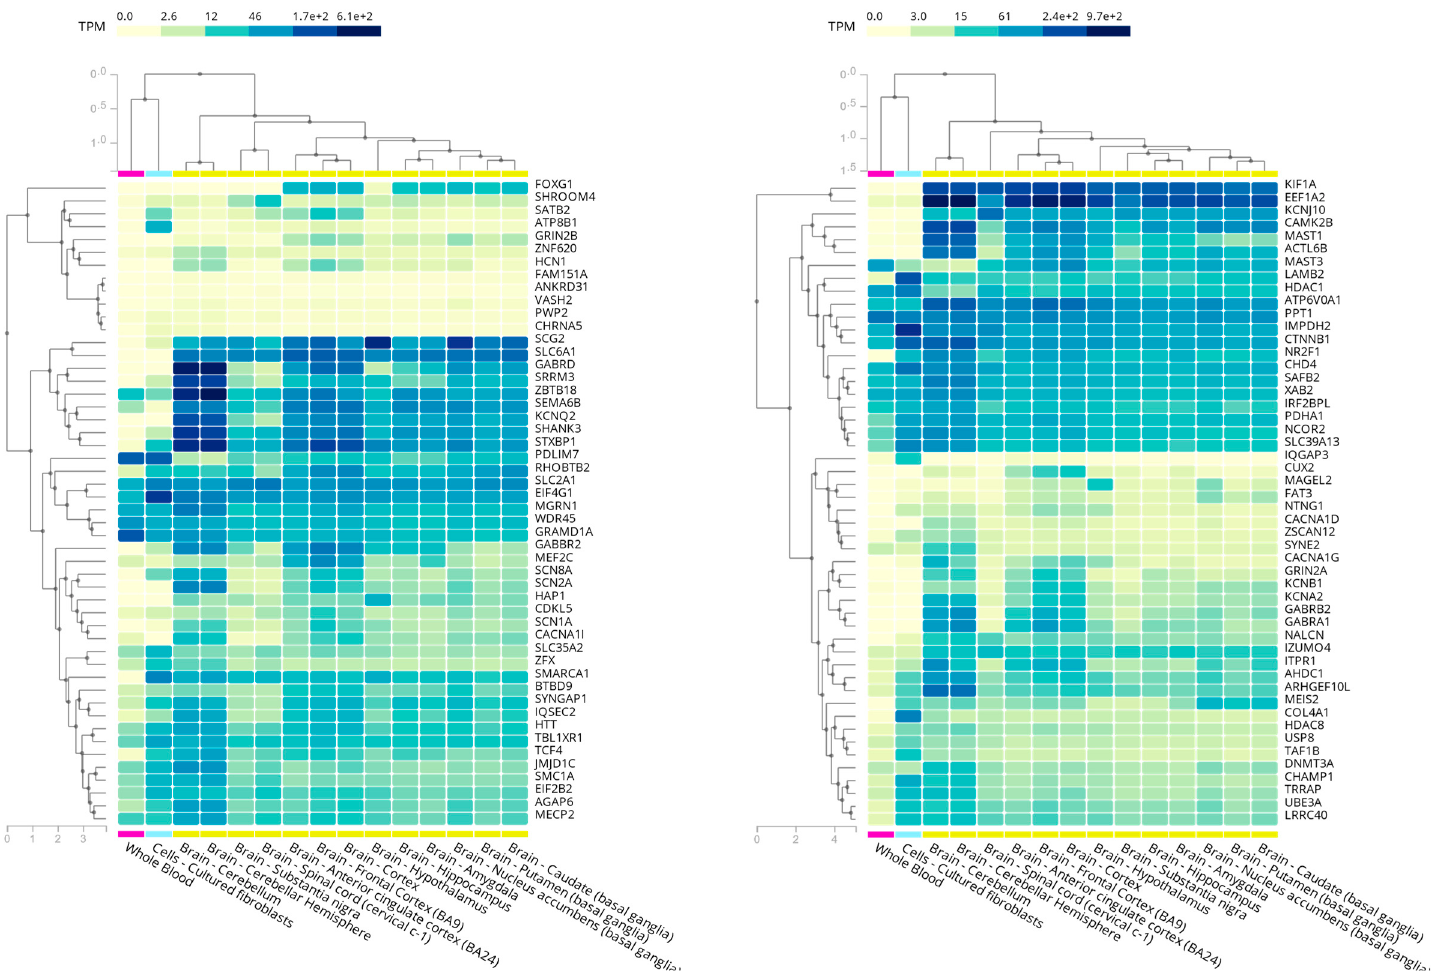
Figure 1. RTT-spectrum-related genes in whole blood, cultured fibroblasts, and different brain regions according to GTEx data (obtained from the GTEx portal on 05/18/21).